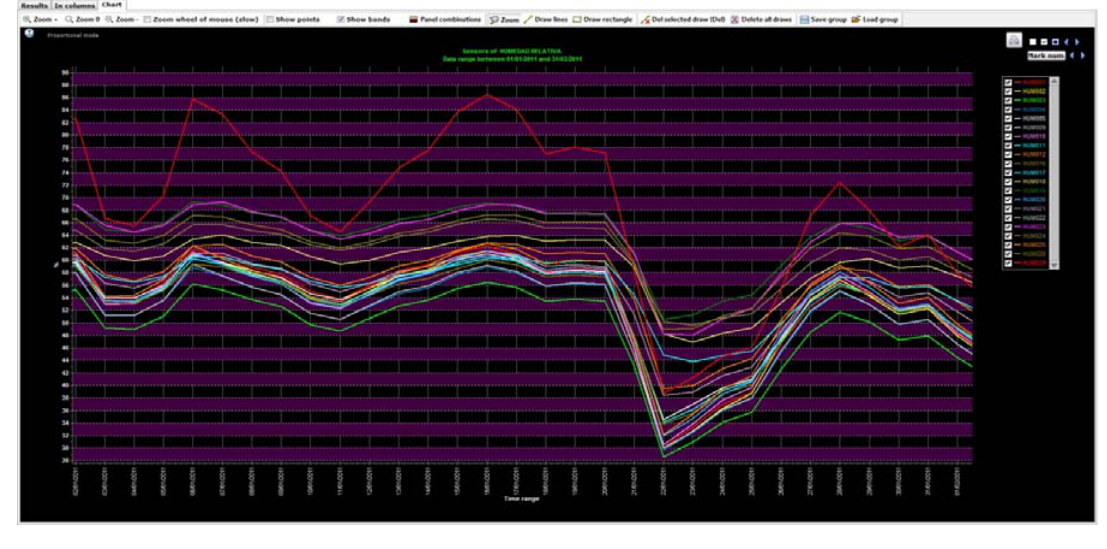
Figure 9. Results plotted on a graph (zoom on the figure for more axis